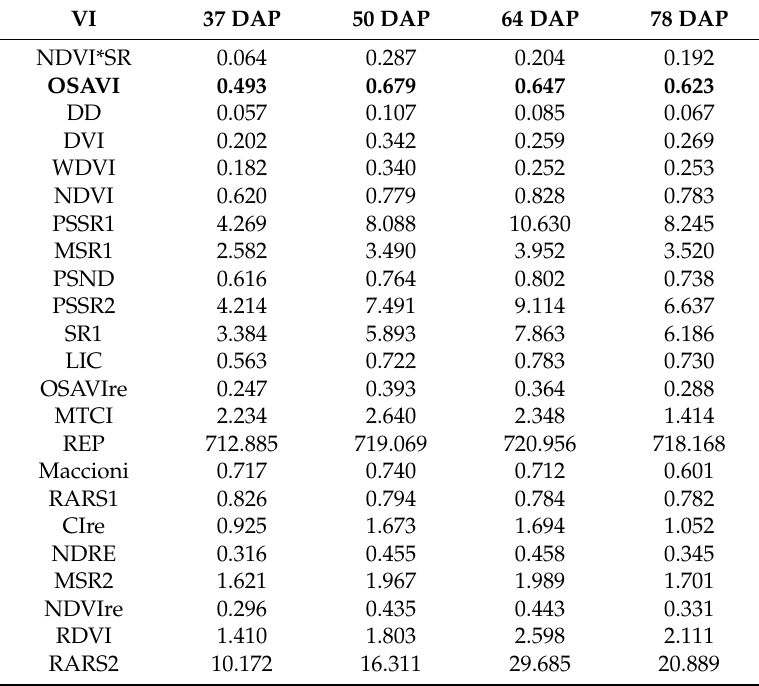
Figure A1. RMSE for ground cover retrieval at SU level by applying vegetation index (VI) threshold to the UAV images. Values after VI labels in the graph indicate the median RMSE for the respective index, considering the validation dataset (i.e., four sampling units per acquisition date). Table A4. Vegetation indices (VIs; Table A2) thresholds obtained after optimization for background removal in UAV images. Different values were derived for each acquisition date in order to adapt background removal to crop development and measurement conditions. Results are ordered following the segmentation performance presented in Figure A1.